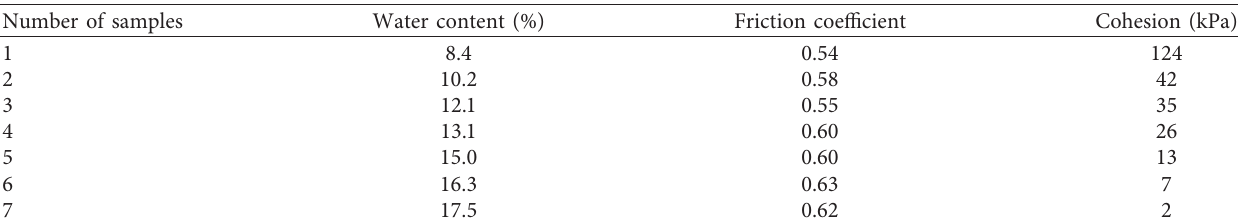
Figure 9: Calculation results of normal stress in slip zone of Hejia landslide. Table 4: Strength index of soil in slip zone of Hejia landslide under different water content.